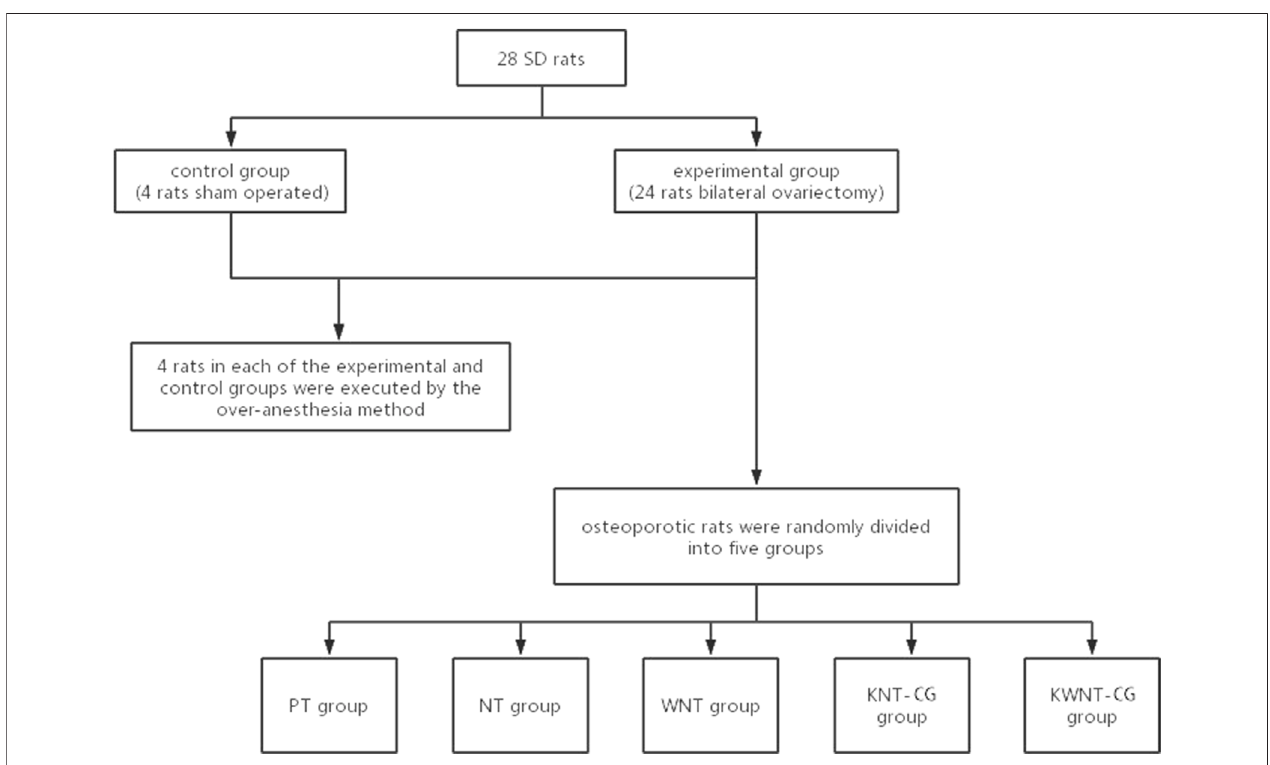
FIGURE 1 | Animal experimental